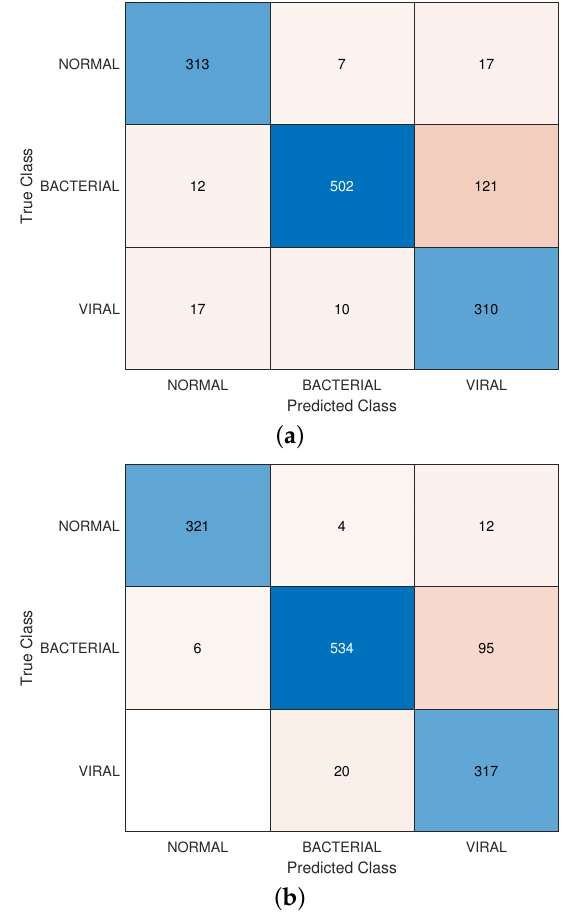
Figure 8. The confusion matrix of the proposed model in a normal vs. bacterial vs. viral CXR images classification fashion using ( a ) deep features and ( b ) proposed features. Table 3. Comparison of early-layer and deep-layer accuracy for pneumonia diagnosis using most off-the-shelf deep networks vs. proposed densely-connected residual